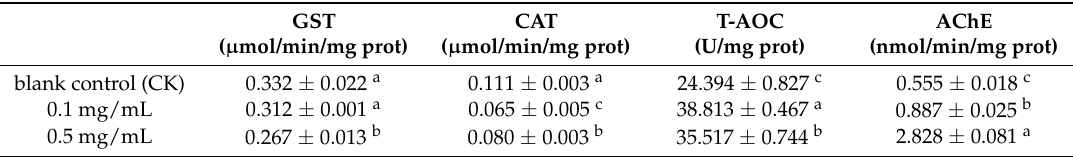
Table 2. Activities of glutathione S-transferase (GST), catalase (CAT), and acetylcholinesterase (AChE) and total antioxidant capacity (T-AOC) in H.